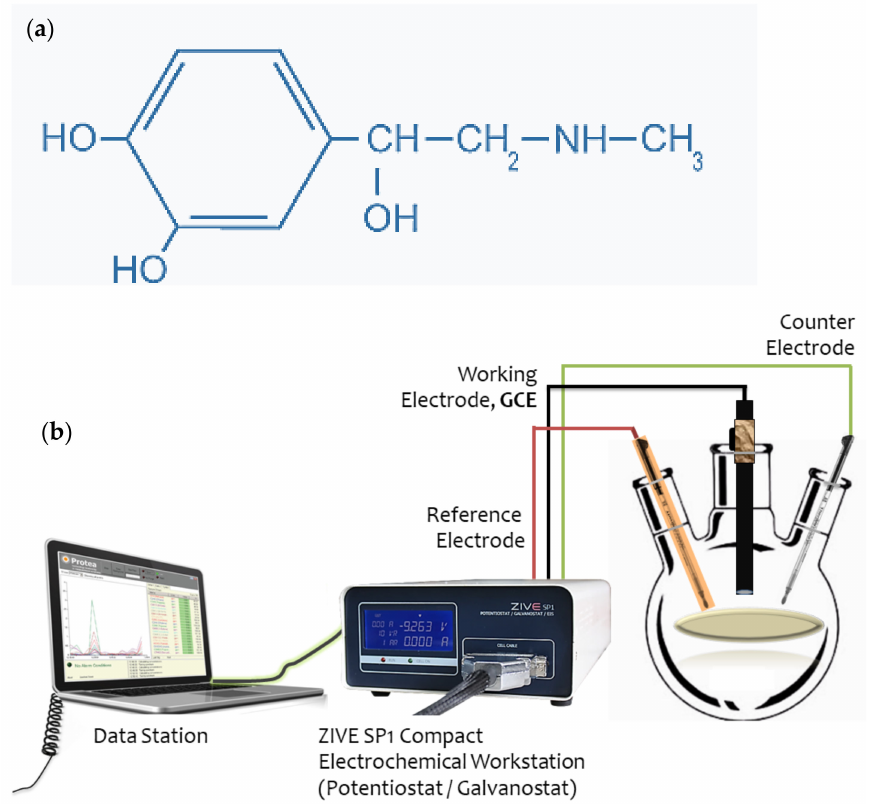
Figure 1. ( a ) Chemical structure of epinephrine, and ( b ) Electrochemical detection system for epinephrine. Table 1. Comparison with epinephrine sensing properties on various sensing